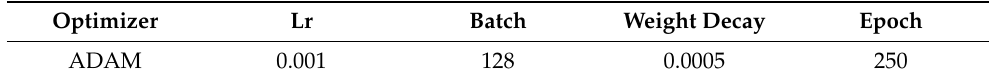
Table 1. Training parameter setting. Optimizer Weight Decay